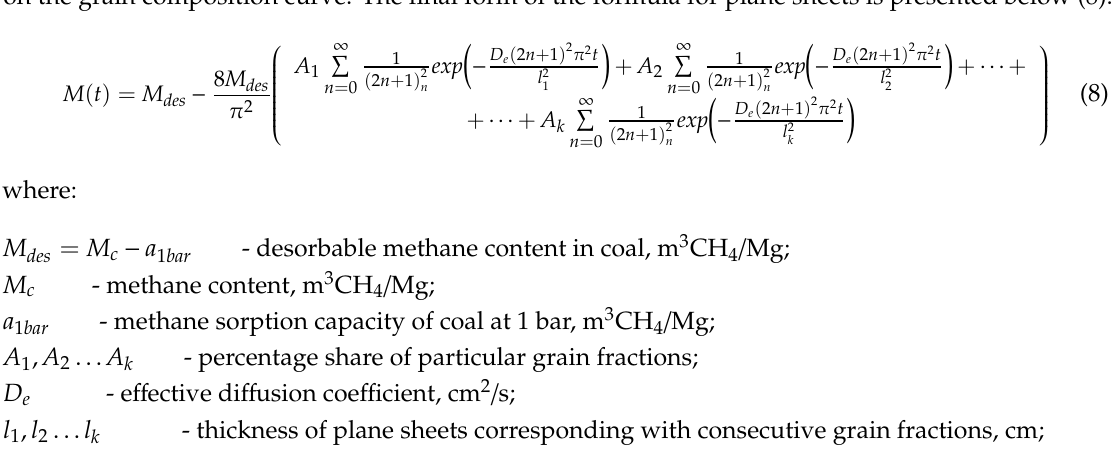
Figure 6. Kinetics of methane accumulation in coal from the Zofi ó wka and Budryk coal